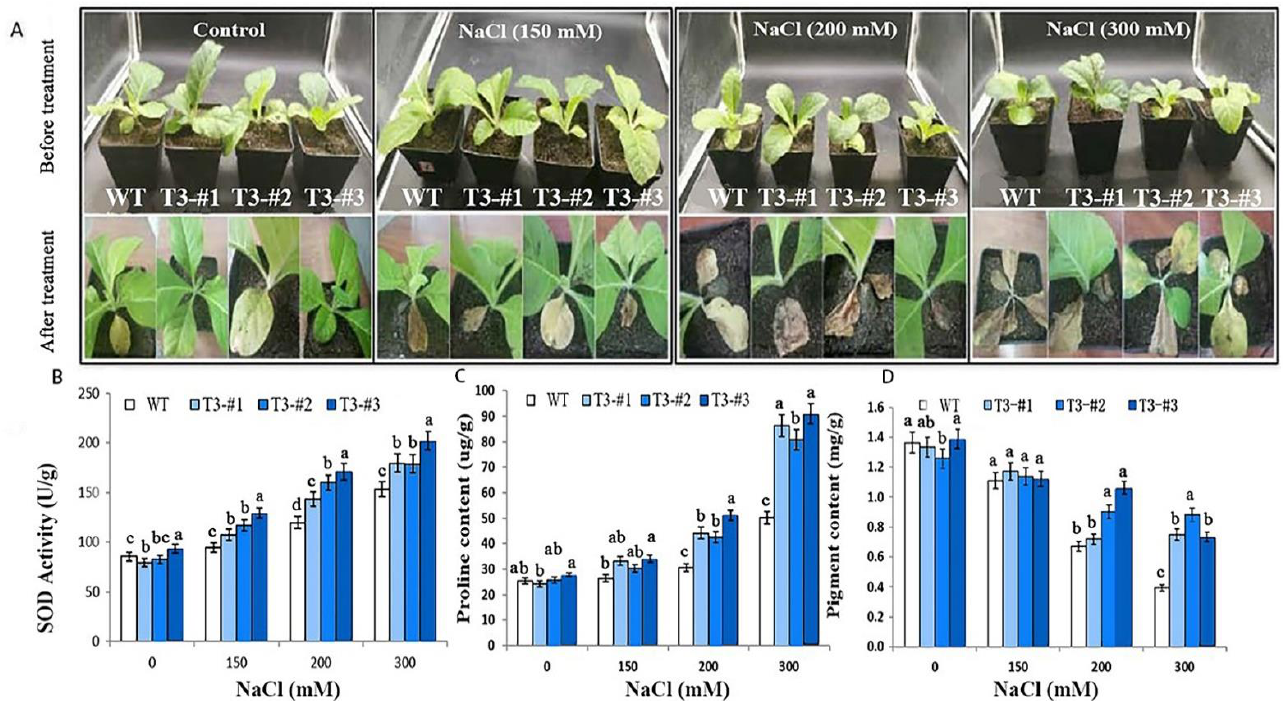
Figure 6. Enhanced salt tolerance in N. tabacum overexpressing AmPAL . ( A ) Plant phenotypes. The upper and lower panels indicated plants before and after treatment, respectively. One control and three NaCl treatment groups (150, 200, and 300 mM, respectively) were included. For each group, one WT and three transgenic plants (#1-3) were shown. ( B – D ): quantification of SOD, proline, and chlorophyll, respectively. Marking: The letters on the bar chart are marked for significance analysis. Where there is one same marking letter, the difference is not significant; where there is different marking letters, the difference is significant. The more different letters are, the more significant they are.